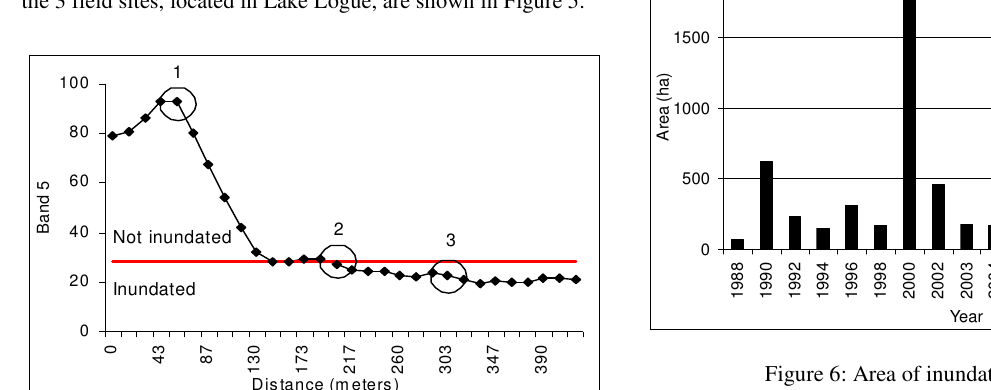
Figure 6: Area of inundation per